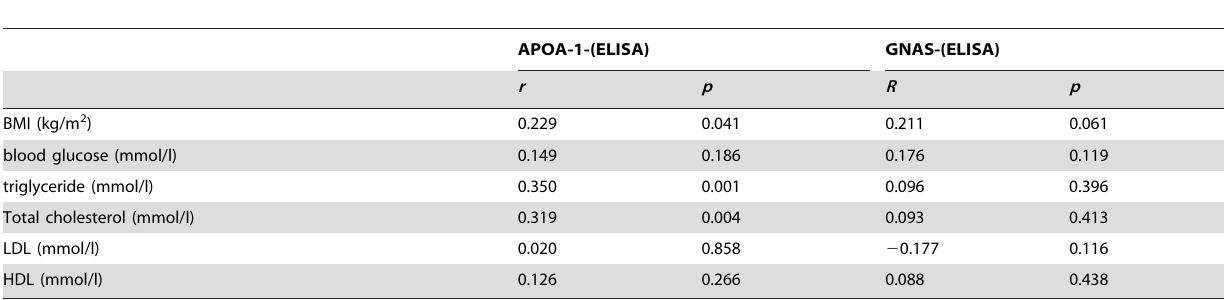
Table 6. Partial correlations between changes in APOA-I, GNAS and changes in metabolic measures after controlling for age, gender and family history of diabetes (N